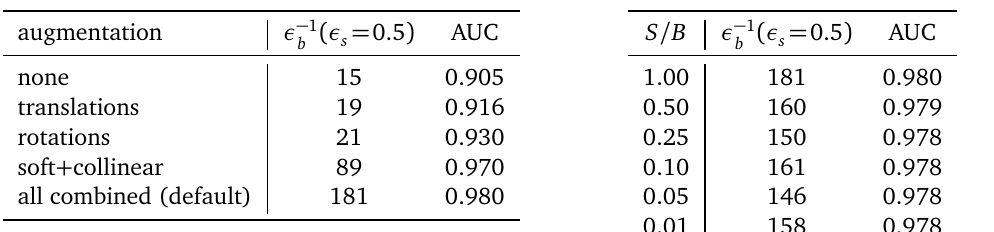
Table 2: Left: classification results for JetCLR trained with different symmetries and augmentations and S / B = 1. The default setup includes translation and rotation symmetries, combined with soft and collinear augmentations. Right: classification results for the combined (default) symmetries and augmentations, trained with dif- ferent signal-to-background ratios S / B